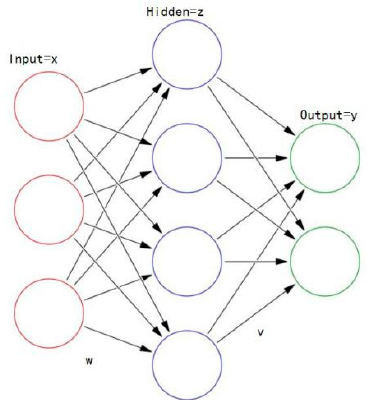
Figure 1. The architecture of the neural network.